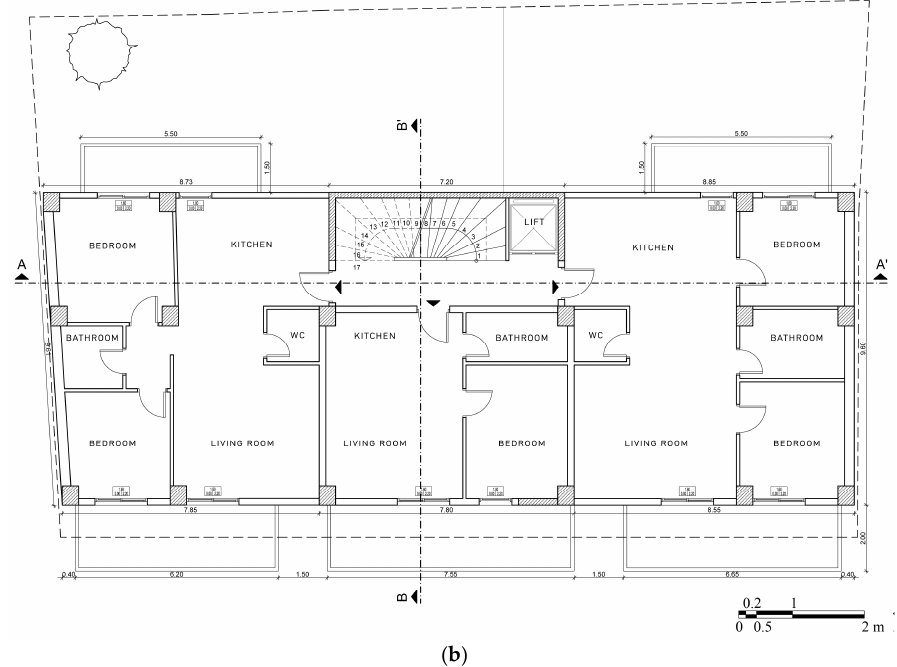
Figure A1. Reference building drawings of ( a ) the pilotis—ground floor level plan and ( b ) the typical floor plan (1st, 2nd and 3rd floor).